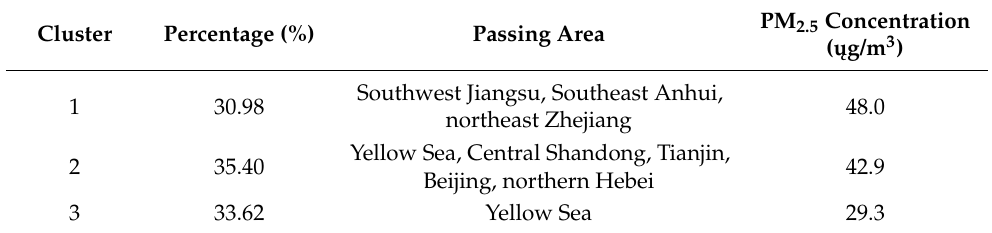
Table 3. Trajectory clustering characteristics of Yancheng, from 2017 to 2021.